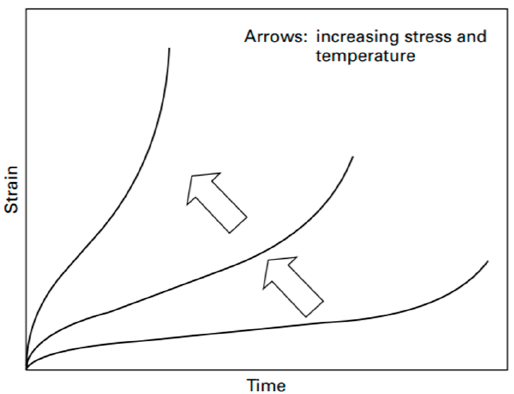
Figure 7. Schematic creep behaviour varying with stress and temperature [23]. Deformations (elastic plus plastic strain) due to creep are divided into three different regimes.